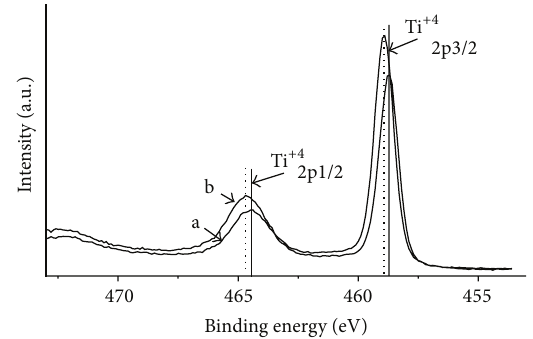
Figure 4: XPS spectra of Ti element of P25 and Mo-P25, respec- tively. a: Ti element of P25. b: Ti element of Mo-P25.